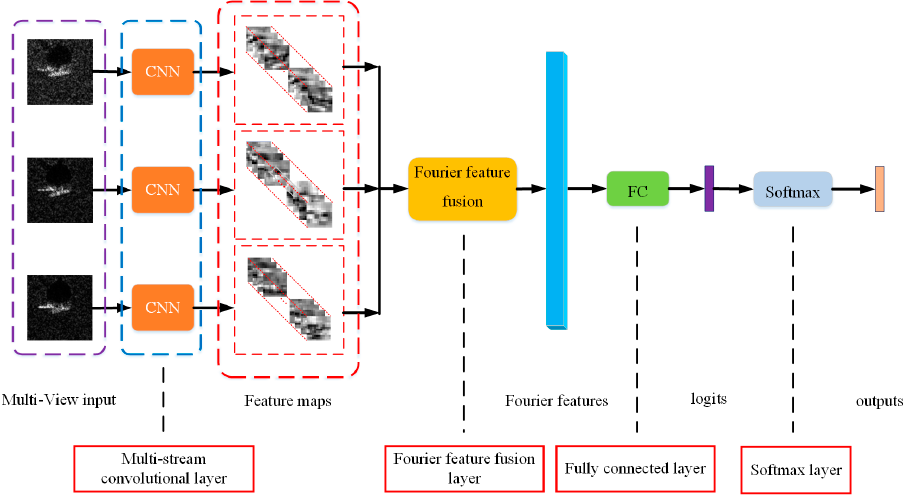
Figure 1. The learning structure of the proposed multi-stream convolutional neural network (MS-CNN); that is, the three-views MS-CNN.